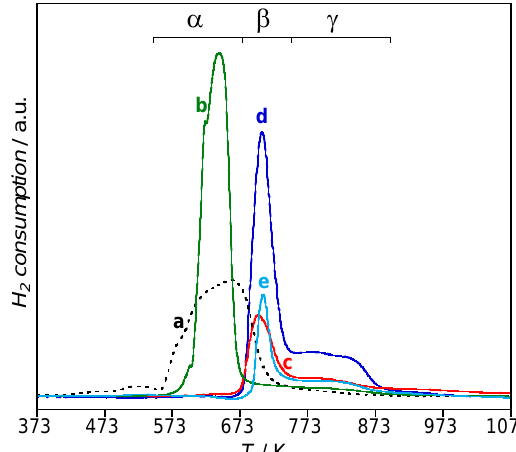
Figure 4. TPR profiles for NiO and NiO/ZrO 2 catalyst precursors. ( a ) Unsupported NiO; ( b ) 5.1NiO/Z m ; ( c ) 1.8NiO/Z m ; ( d ) 4.8NiO/Z hy ; ( e ) 1.7NiO/Z hy . α, β and γ: temperature ranges for the reduction of NiO species interacting differently with the support. Table 3. H 2 -TPR results for NiO and Ni/ZrO 2 catalyst precursors.